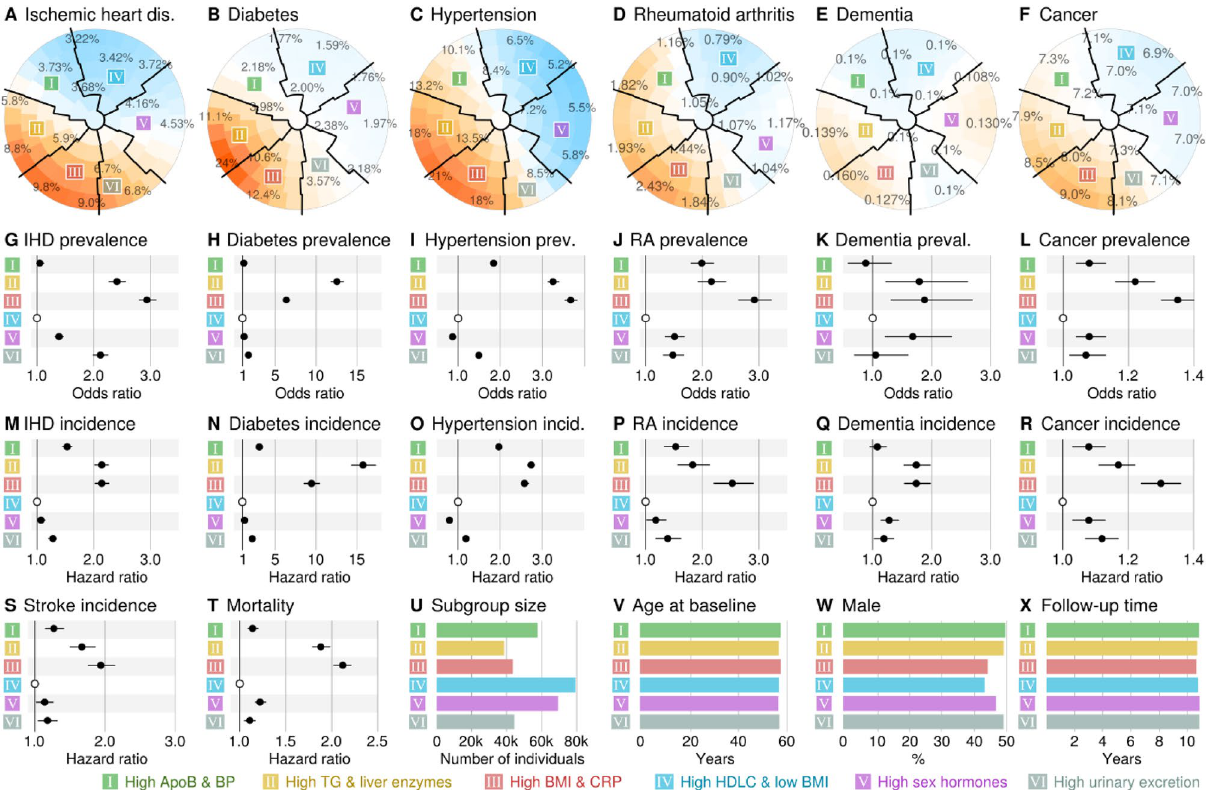
Figure 5. Comparison of morbidity between the SOM subgroups. Percentage of individuals with a disease at baseline across the map districts ( A–F ). Odds ratios for disease prevalence across subgrups based on logistic regression adjusted for age, sex and assessment center ( G–L ). Hazard ratios for incident disease or mortality based on Cox regression adjusted for age, sex and assessment center ( M–T ). Maximum follow-up time available across any clinical end-point ( X ).